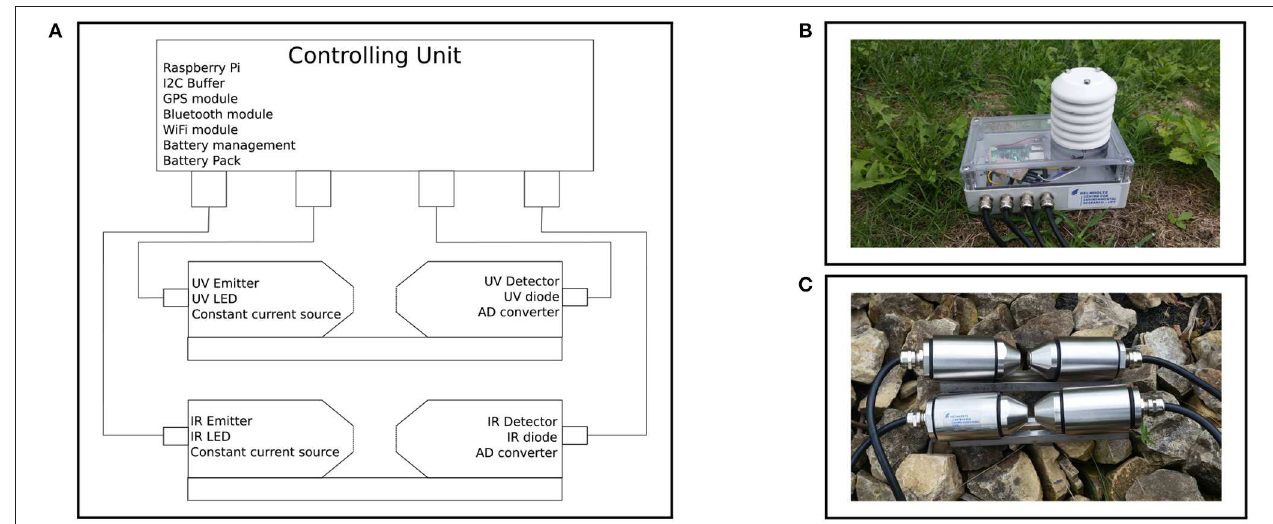
FIGURE 2 | (A) shows a schematic drawing of the sensor system. (B) shows the control unit with the Raspberry Pi, GPS receiver, and WiFi module as well as the battery pack. Four cables are connected to the emitters and detector units of the UV channel (DOM) and IR channel (turbidity); the white attachment on the top of the control unit is used to measure temperature and humidity. The illustration in (C) shows the IR sensor unit at the top and the UV sensor unit at the bottom, with both receiving and transmitting sensor heads mounted opposite each other on a metal guide. Inside there is an LED as emitter and a photodiode as detector in combination with an AD-converter. A constant current source and voltage regulator are integrated on the emitter side for stable operation. The control unit and the sensor modules are connected by